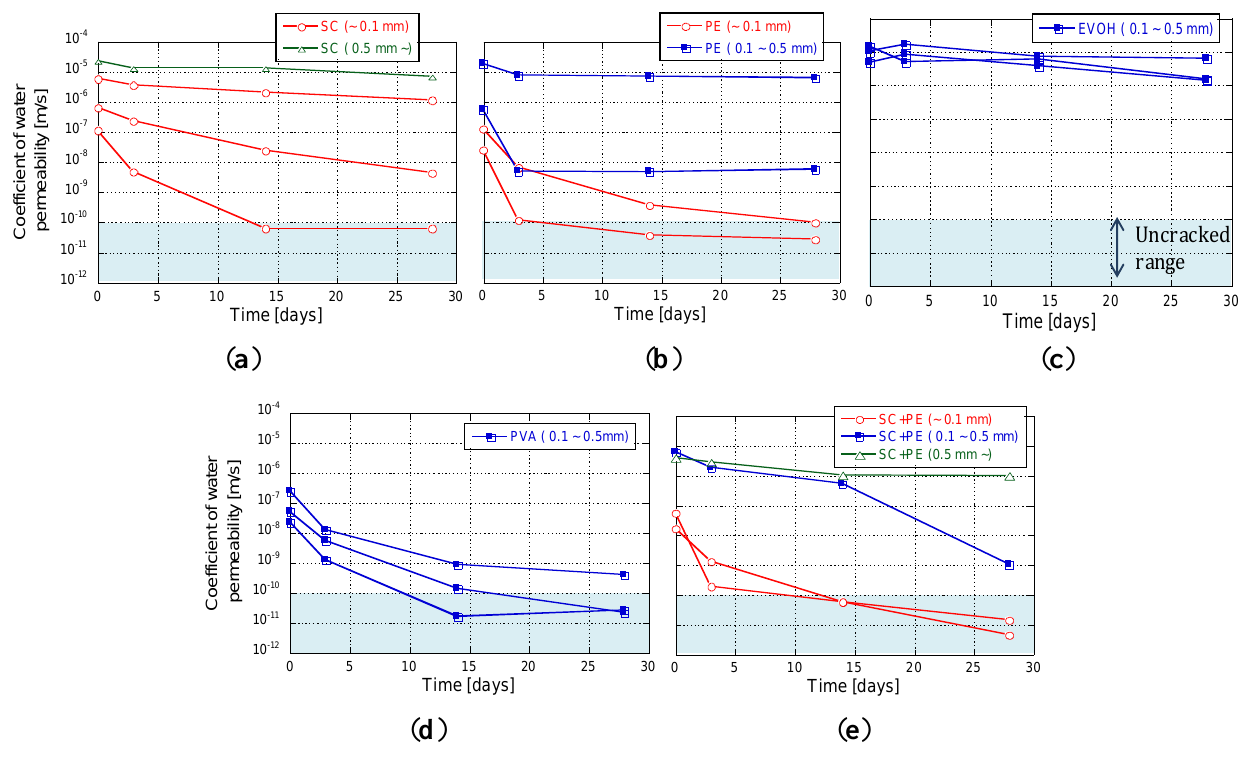
Figure 6. Relationship between time and coefficient of water permeability: